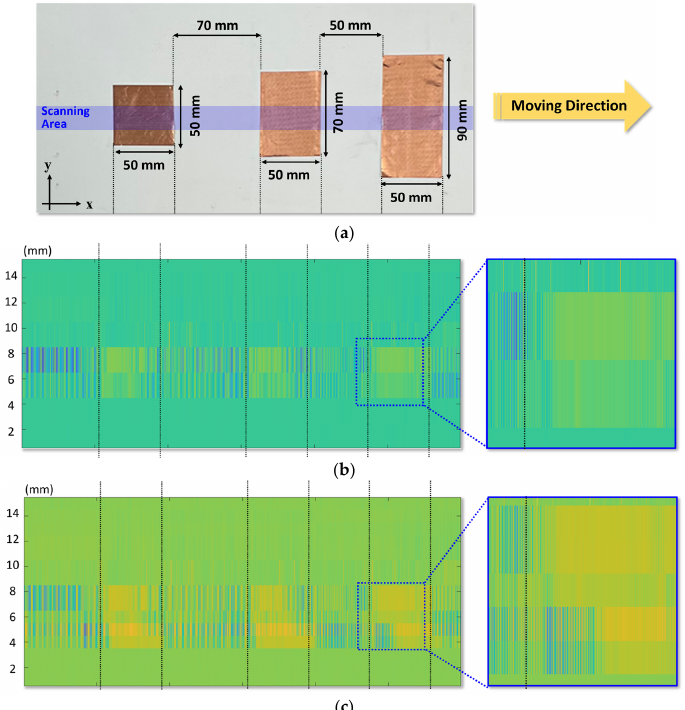
Figure 15. Measured sub-terahertz images: ( a ) Photo of the target object on the conveyor belt with the physical dimension of the object. ( b ) Image obtained by using the conventional array with one column consisting of 16 modules. ( c ) Image obtained by using the proposed array with two columns consisting of 16 × 2 modules.